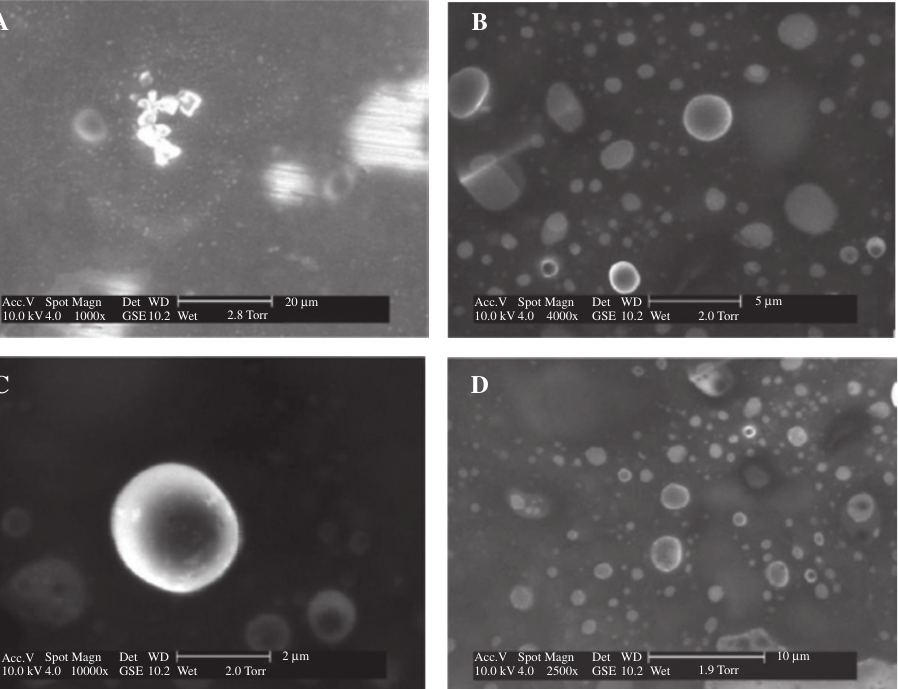
Figure 4: Environmental scanning electron micrographs of ibuprofen liposome made of phospholipid and cholesterol (4 : 1 molar ratio) dispersed in 0.01 M phosphate-buffered saline (pH 7.4). Stabled liposomal structured were observed when they were subjected to con- trolled dehydration at an operating pressure of 2.8 Torr (A), 2.0 Torr (B), 1.9 Torr (C), and even 1.9 Torr (D). Scale bars are denoted within the individual figure. Reprinted from Liao et al. [52].